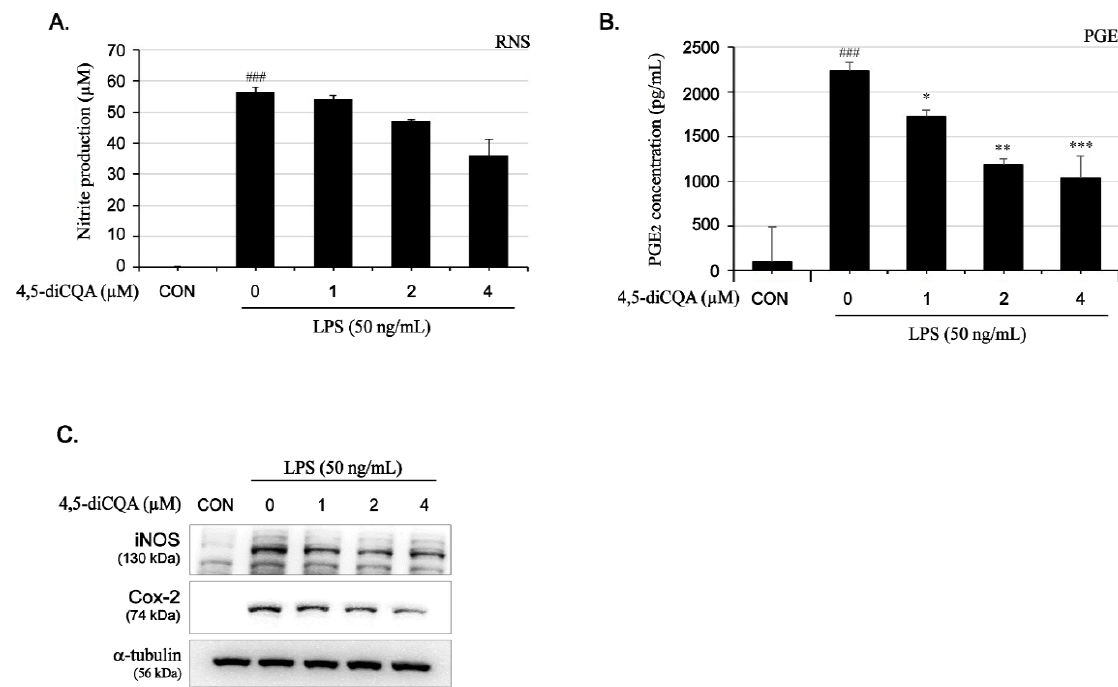
Figure 2. Inhibitory effects of 4,5-diCQA on LPS-induced nitrite, PGE 2 , iNOS, and COX-2 in RAW264.7 cells-stimulated with LPS. Cells were pretreated with 4,5-diCQA (1, 2, and 4 µM) for 1 h, followed by LPS (50 ng/mL) stimulation for 24 h. ( A ) Nitrite production was determined in the culture medium using Griess reagent. ( B ) PGE 2 production was determined in the culture medium using enzyme-linked immunosorbent assay (ELISA). ( C ) Expression of iNOS and COX-2 was determined using Western blot analysis. α -Tubulin served as an internal control. Expression results are represented as the mean ± SD of three independent experiments. ### p < 0.01 compared with control group; * p < 0.05, ** p < 0.01, and *** p < 0.001 compared with LPS-treated group. CON; control, RNS; reactive nitrogen species, PGE 2 ; prostaglandin E 2 , iNOS; inducible nitrite oxide, COX-2; cyclooxygenase-2.